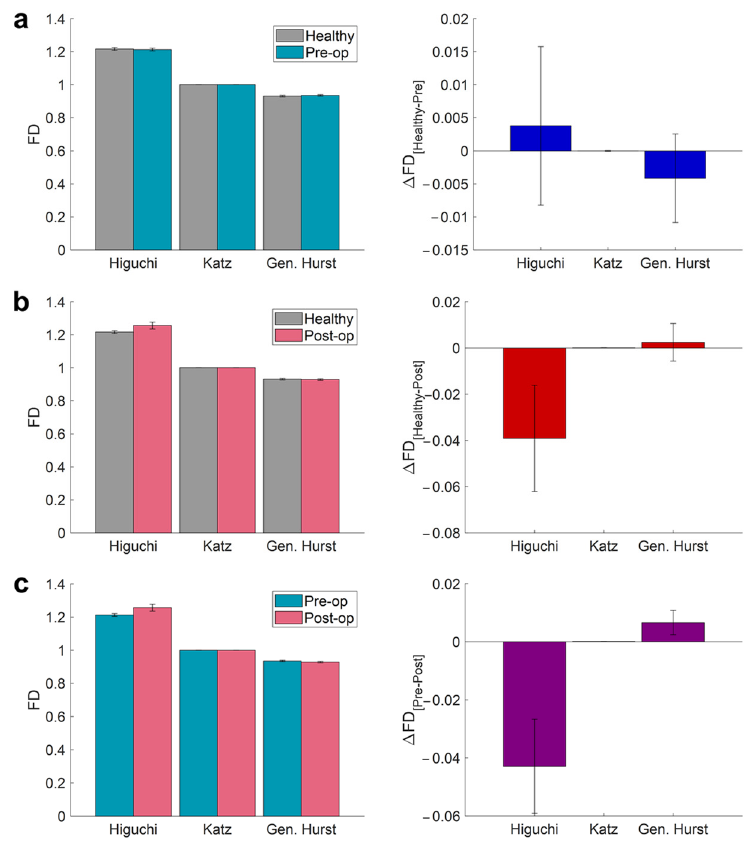
Figure 6. Average values of Higuchi FD, Katz FD, and generalized Hurst exponent (left panel) along with the difference in FD values (right panel) obtained from ELEback measures for ( a ) healthy and preop ( p -value Higuchi = 0.535; p -value Katz = 0.535; p -value Hurst = 0.318), ( b ) healthy and postop ( p -value Higuchi = 0.001; p -value Katz = 0.002; p -value Hurst = 0.620), and ( c ) preop and postop ( p -value Higuchi = 0.018; p -value Katz = 0.018; p -value Hurst = 0.028)